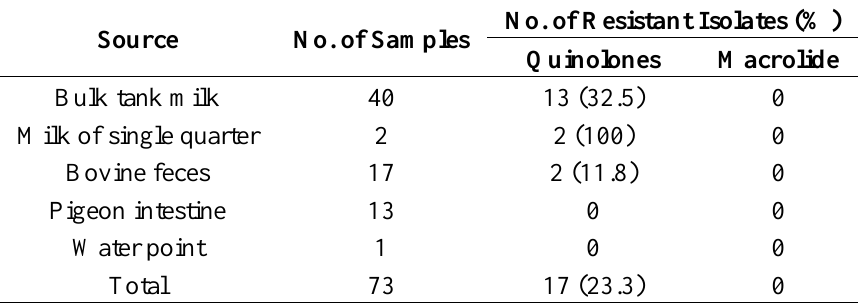
Table 1. Antimicrobial resistance pattern of C. jejuni